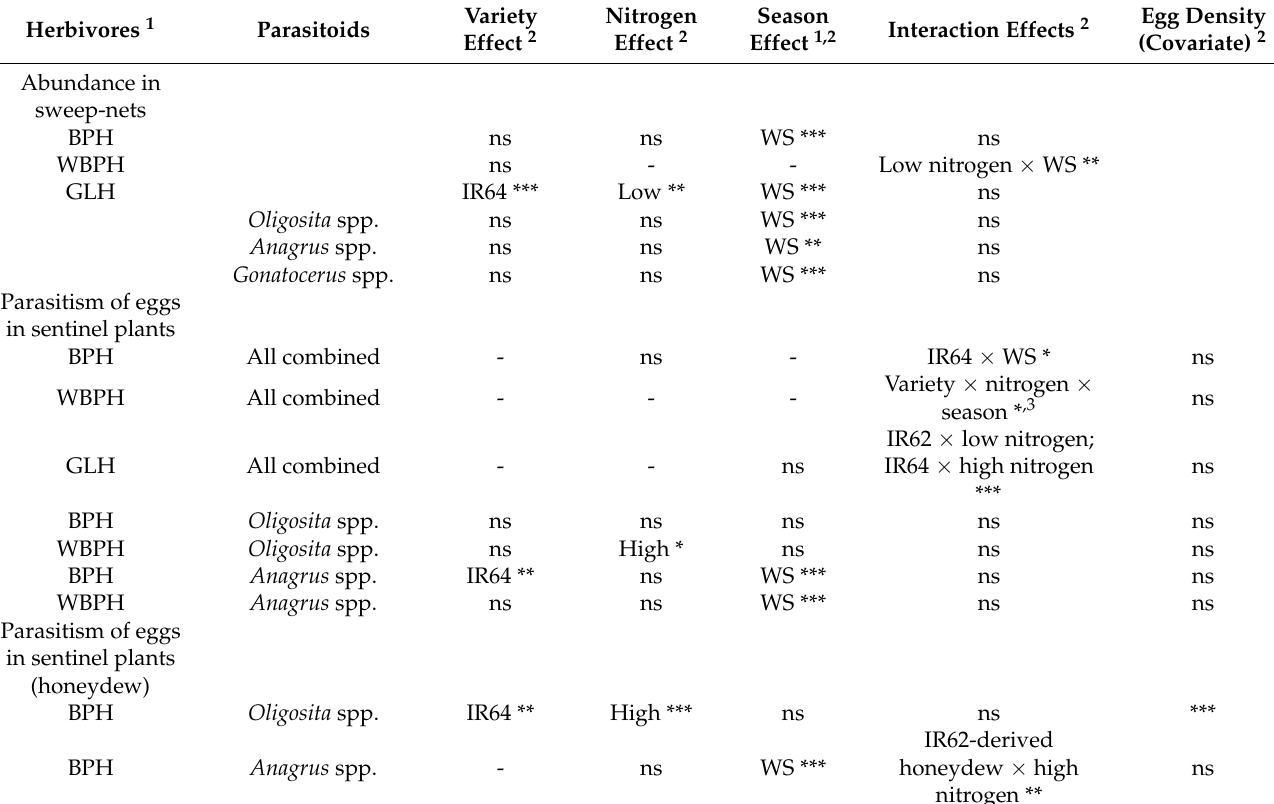
Table 2. Summary of results from field experiments on the effects of variety (IR62= resistant or IR64 = susceptible), nitrogenous fertilizer level (low = 0 kg N ha − 1 or high = 150 kg N ha − 1 ), honeydew (IR62-derived, IR64-derived, or no honeydew) and their interactions on parasitism of planthopper and leafhopper